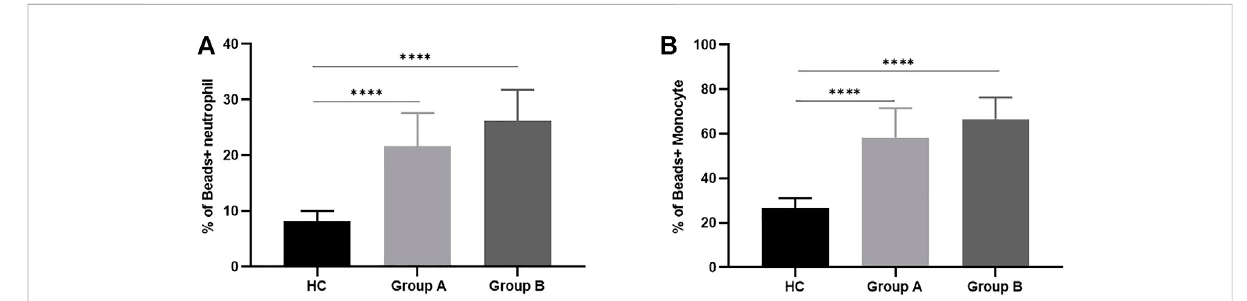
FIGURE 2 Phagocytosisofneutrophilsandmonocytesinhealthycontrolsandpatientswithabdominalsepsisofdifferentagegroups.Note: (A) Represents the phagocytic function of neutrophils. (B) Represents the phagocytic function of monocytes. Group A indicates the cohort of patients aged ≥ 65 years.GroupAindicatesthecohortofpatientsaged < 65 years.Weutilizehowmanyoftheasterisksindicatethemagnitudeofthe p -value. “ **** ” indicates p <